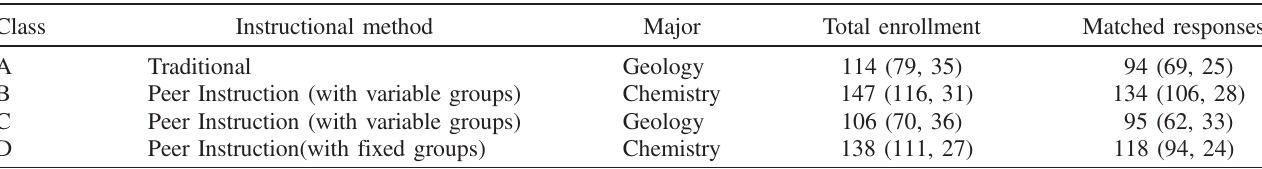
TABLE I. Participants and demographics for each class included in the study [ N (Female,